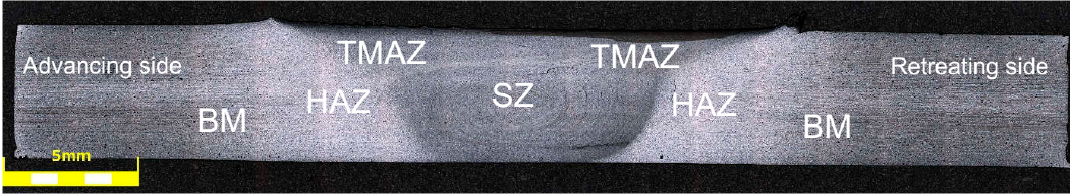
Figure 3. The cross-weld macrostructure of the 5083 FSW